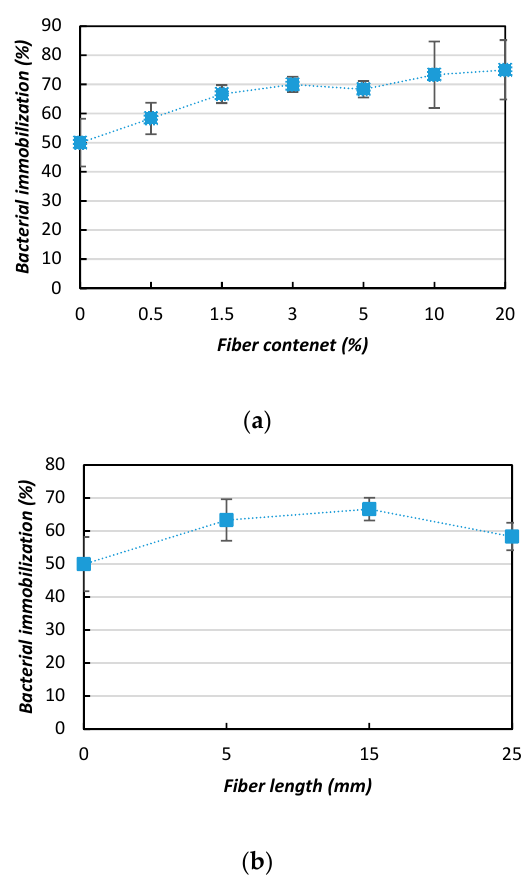
Figure 13. Influence of bacterial retention capacity with the addition of jute fibers: ( a ) fiber content; ( b ) fiber length.